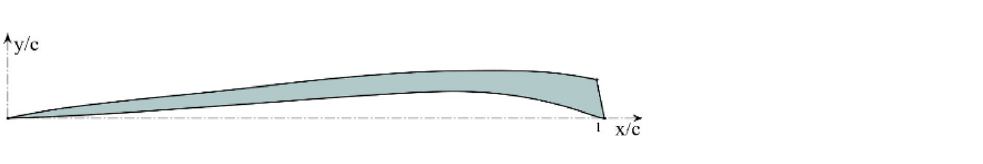
Figure 6. Unrolled generic blade section of HL002